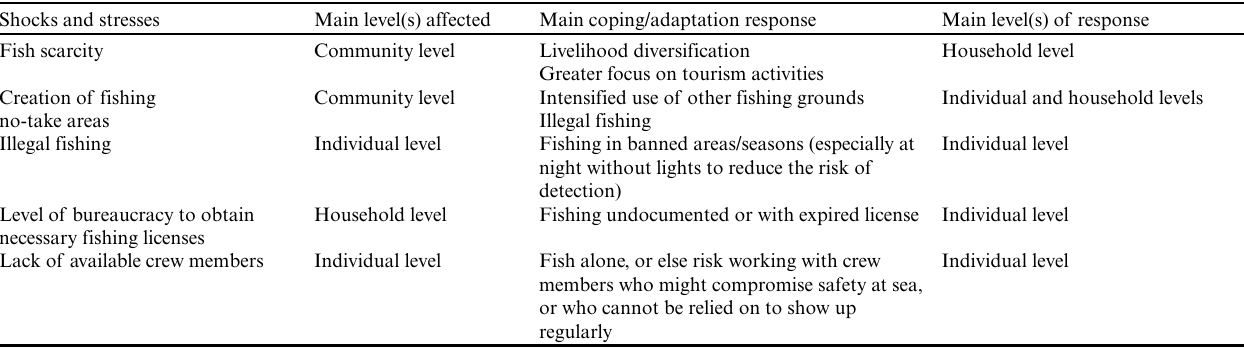
Table 2 . Stresses and shocks described by participants, the main level affected, responses, and the level at which responses took